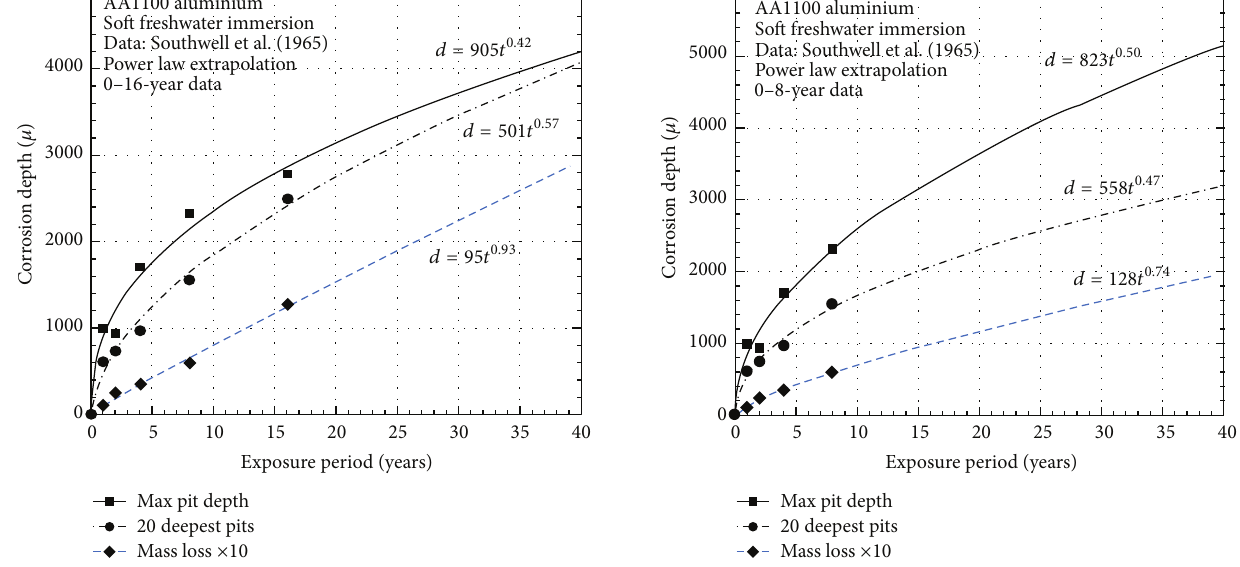
Figure 17: Data for AA1100 in freshwater shown in Figure 10 with a power law fitted to data for 0–16 years extrapolated to 40 years. The expressions for each fitted power law function are shown.